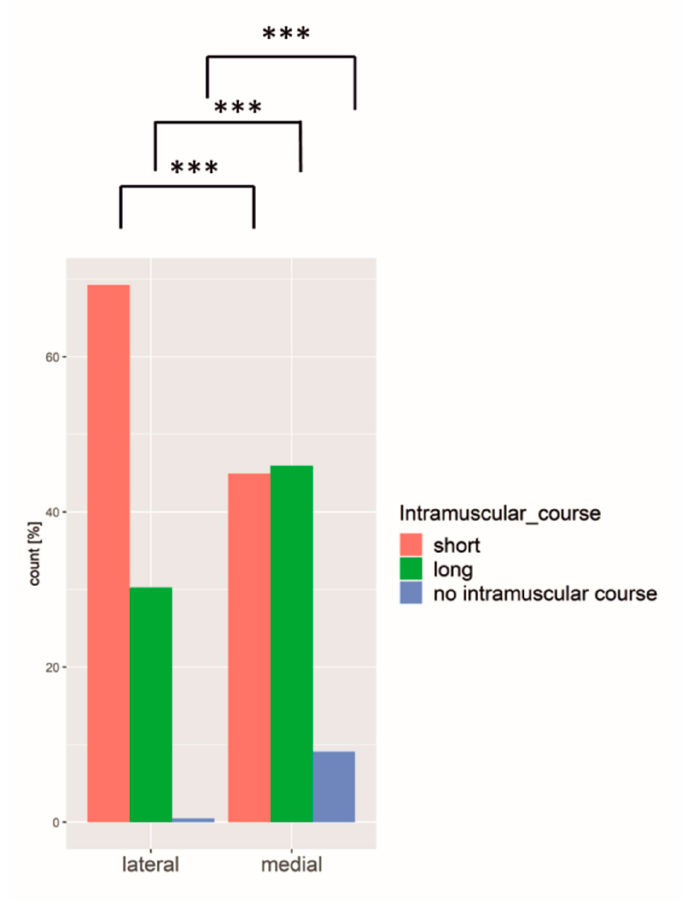
Figure 6. Medial row perforators had a more equally distributed intramuscular course, whereas lateral perforators more often had a short intramuscular course. *** = p ≤